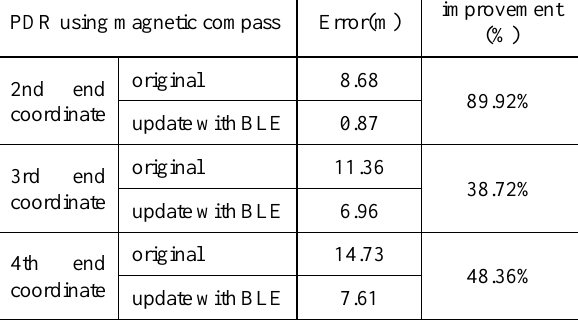
Table 3. The error of PDR using magnetic compass of